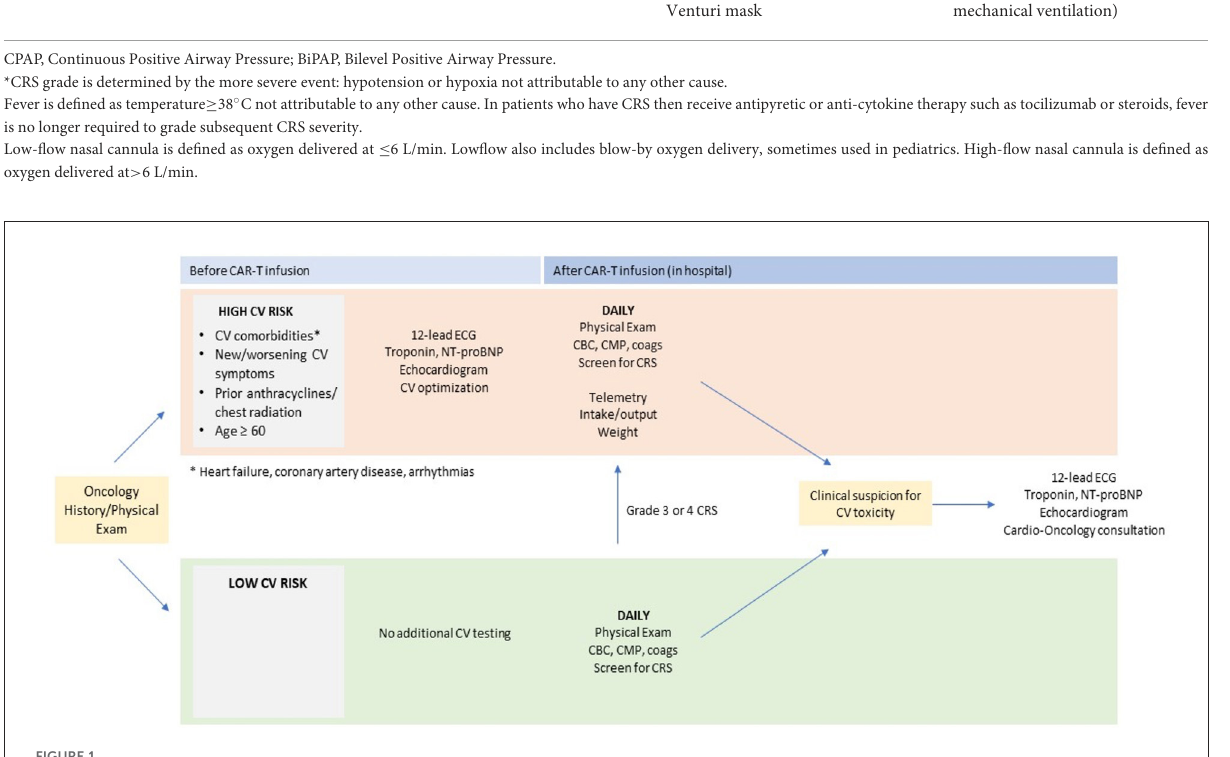
FIGURE1 Proposed pre- and post-CAR T cardiac screening. CAR, chimeric antigen receptor; ECG, electrocardiography; NT-proBNP, N-terminal pro–B-type natriuretic peptide. *arrhythmias, coronary artery disease, heart